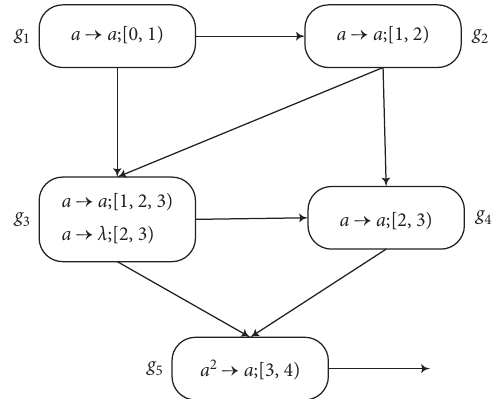
Figure 1: An example of the DSN P system working. Table 1: The results of the